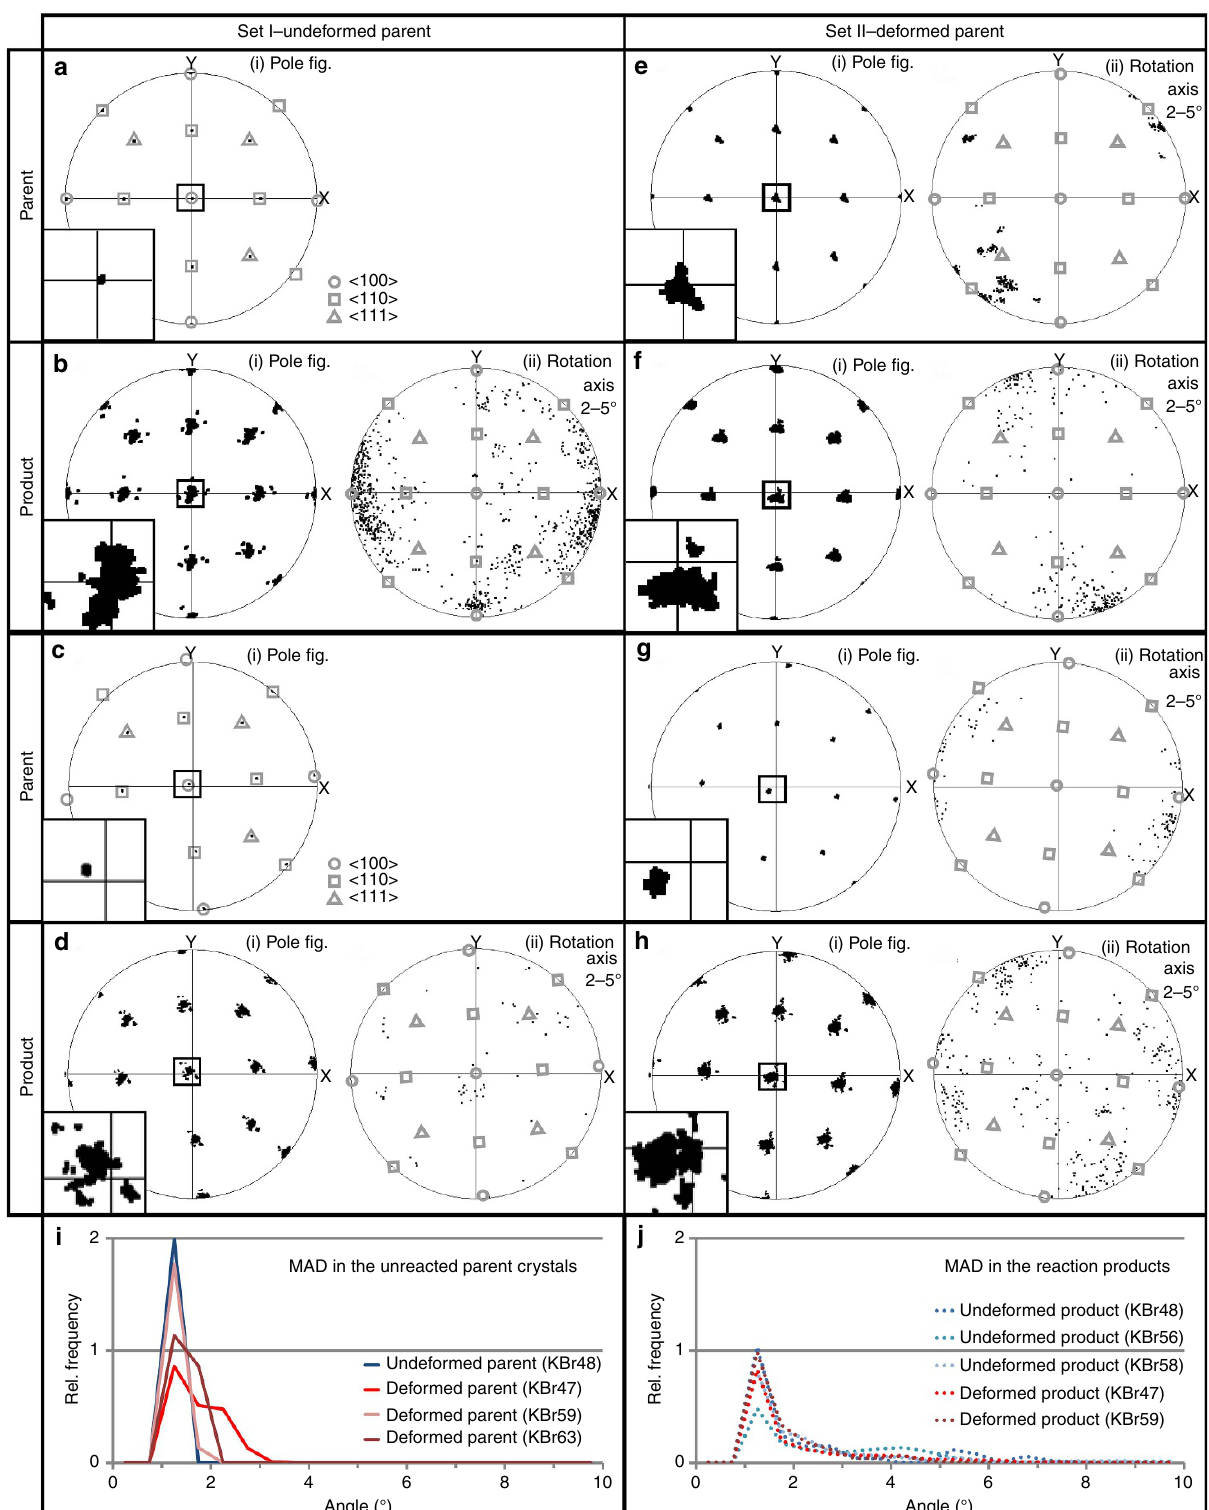
Figure 4 | Crystallographic orientations in parents and products. ( a – h ) Pole figures and rotation axes for unreacted parts (parents) and reacted parts (products) in samples KBr 56, 49, 48 and 47. ( i , j ) Relative frequencies of correlated misorientation angle distribution (MAD) for unreacted ( i ) and reacted parts ( j ) of the experimental